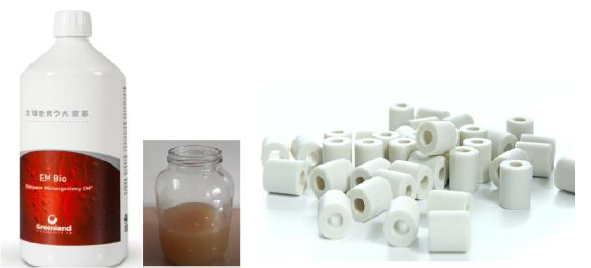
Fig. 4. The commercial form of effective microorganisms in liquid form and ceramic tubes [29, 31] In addition, silver solution and colloidal nanosilver were added to fresh and used oil in the same proportions as for effective microorganisms (2.5 ml and 5 ml per 100 ml of oil). Nanosilver was used for the tests in the commercial form shown in Fig.